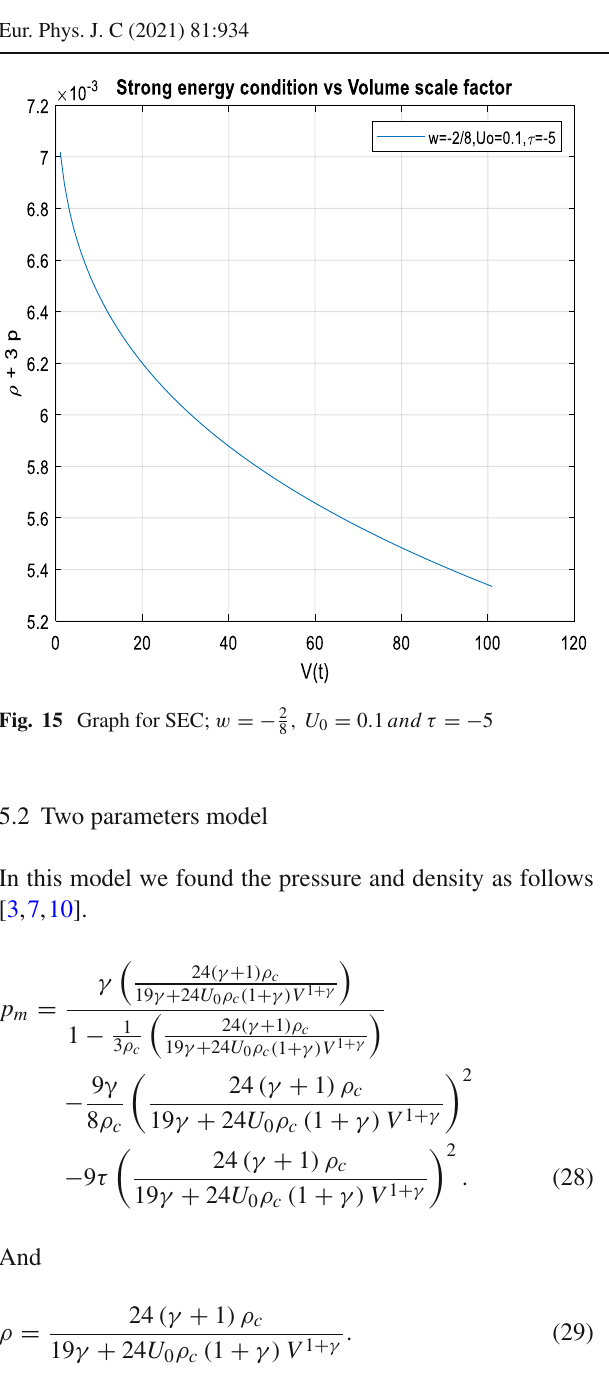
Fig. 17 Graph for WEC; γ = − 2 ; U 0 = 0 . 5 ; τ = − 1 .